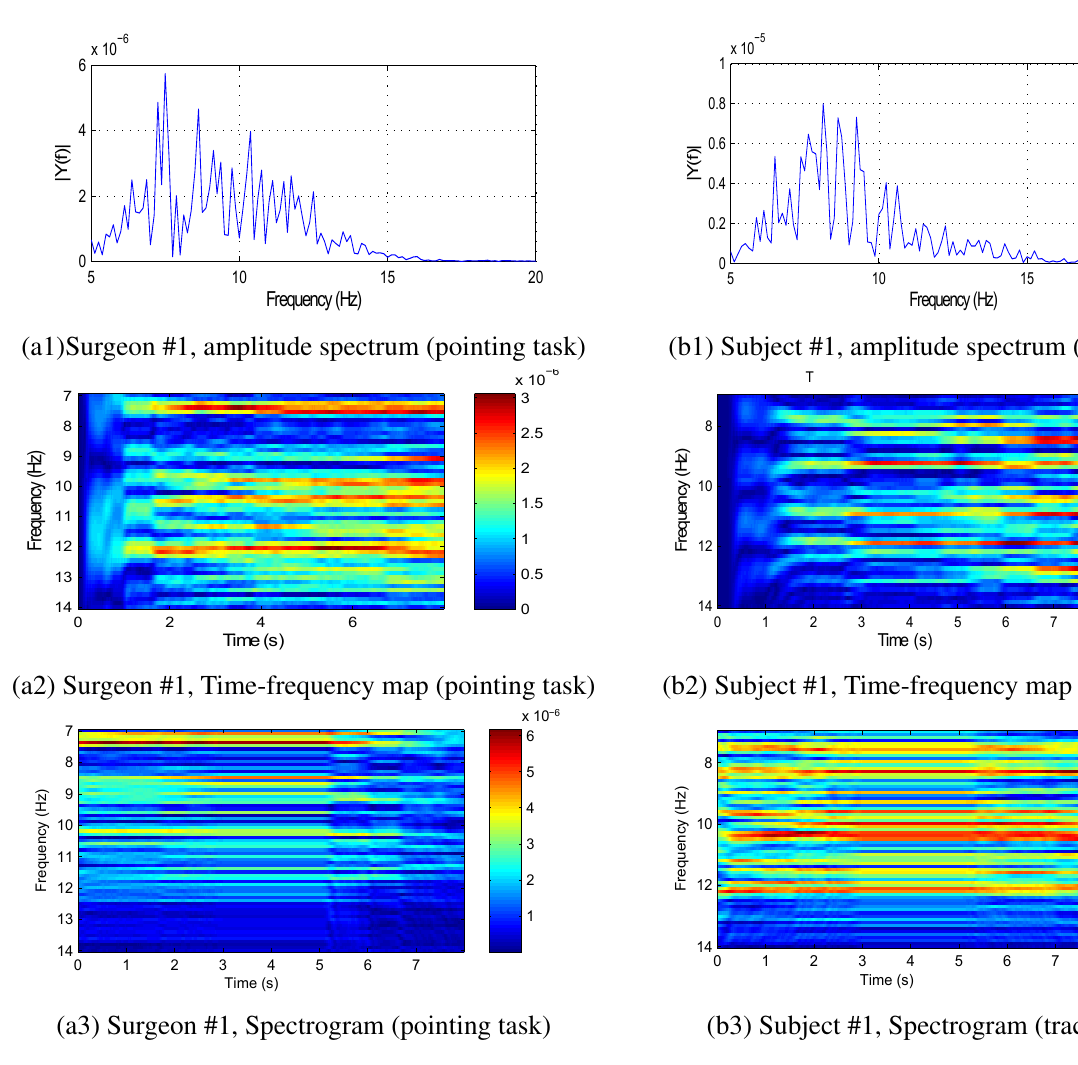
Time-Frequency mapping of surgeon #1 and novice subject #1 in the band of 7–14 Hz.